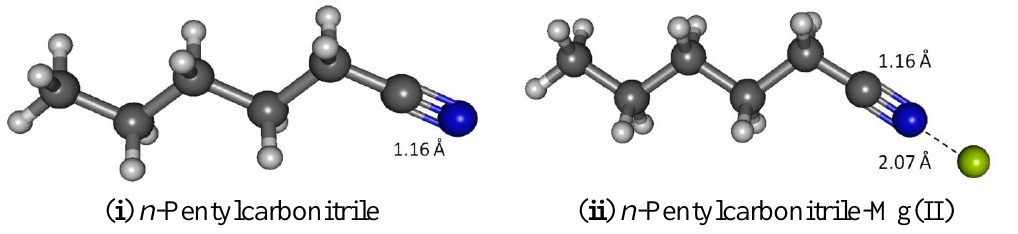
Figure 6. Optimized geometries of n- pentane carbonitrile and its complex with Mg(II).